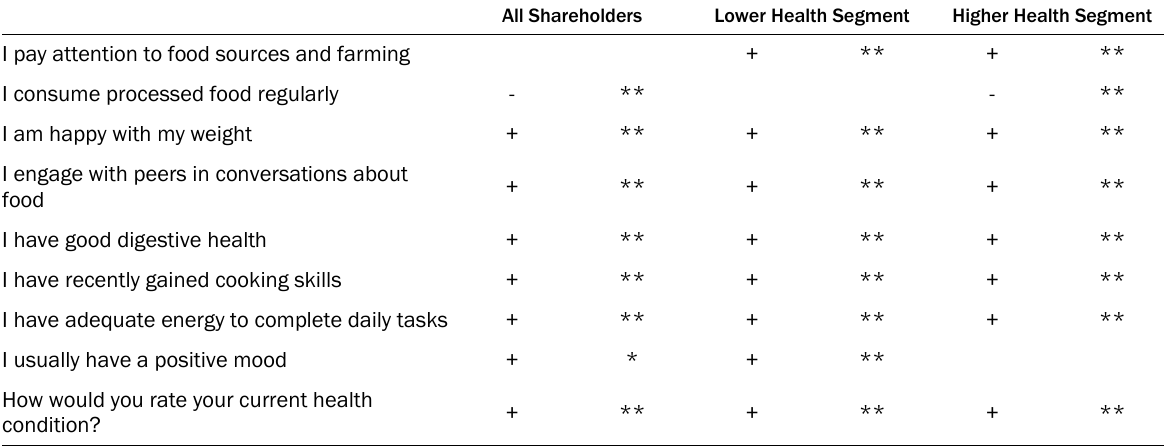
Table 4. Change in Disagreement/Agreement with Statements Following CSA